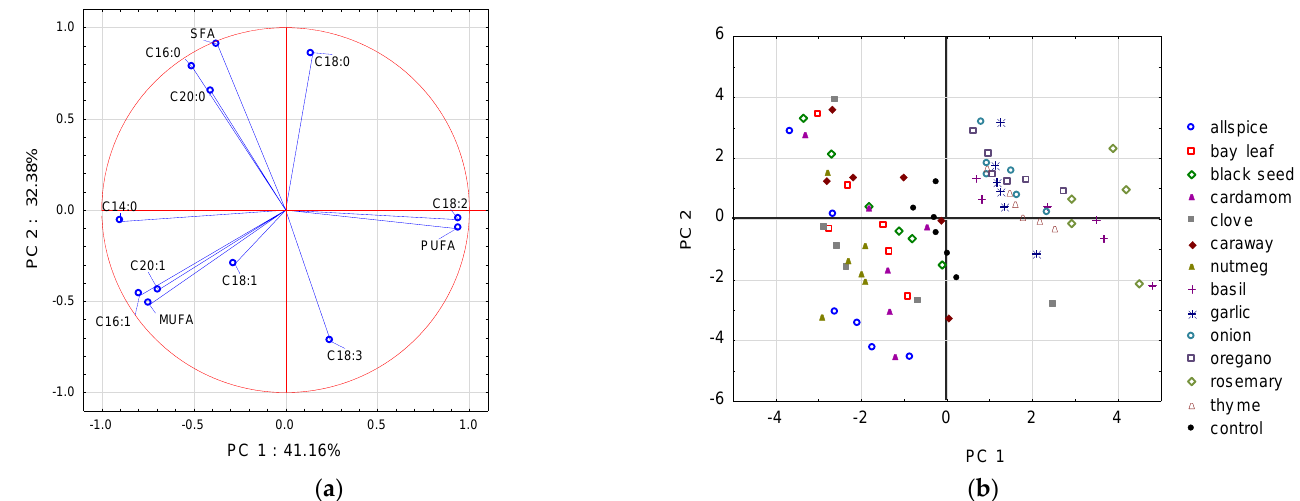
Figure 2. Projections of the ( a ) variables (fatty acids) and ( b ) scores (plant extracts) for raw pork meat samples onto the factor plane defined by principal components (PC1 and PC2).